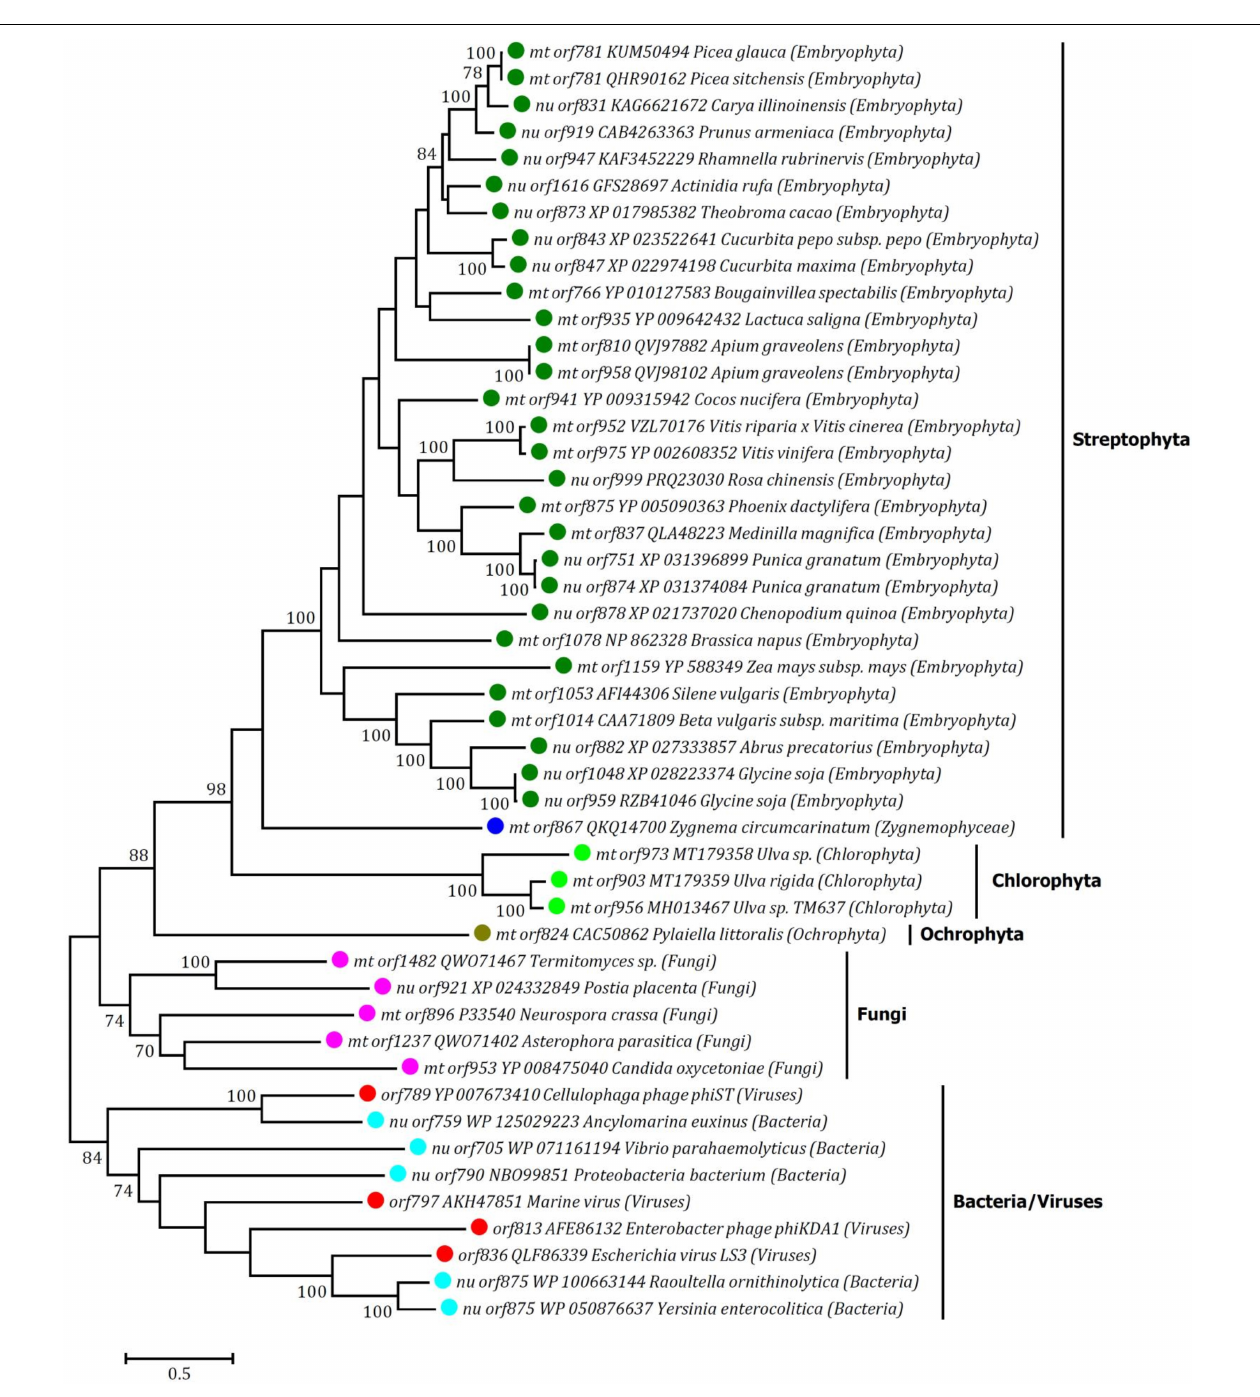
FIGURE 5 | Phylogenetic tree based on Maximum Likelihood (ML) analysis of amino acid (aa) sequences of 48 RNA polymerase (Rpo) domains from Rpo proteins. The ML analysis was conducted with 1,000 bootstrap replicates using MEGA 7.0. The bootstrap support values greater than 70% were displayed at branches. Branch lengths were proportional to the amount of sequence change, which were indicated by the scale bar below the trees. The tree was rooted with Rpo proteins from bacteria and viruses as